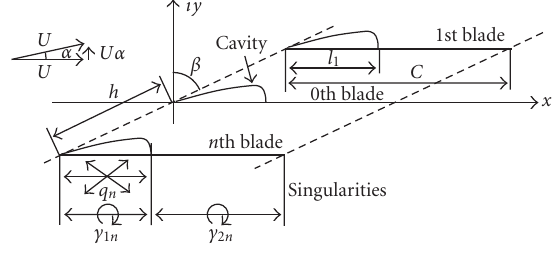
Figure 1: Model for present